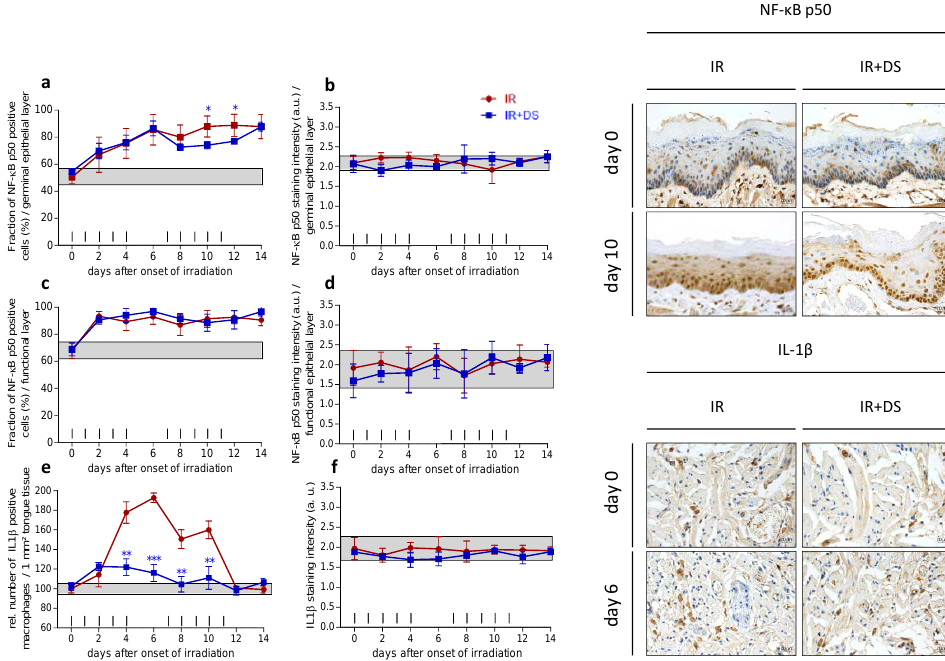
Figure 3. Effect of DS on irradiation-induced inflammatory changes. The relative number of NF- κ B p50 positive epithelial cells and their respective staining intensity were analyzed in the germinal ( a , b ) and functional compartments of the lower tongue epithelium, respectively ( c , d ); IL-1 β expression occurred exclusively in macrophages, which were scored in the deeper tongue tissue ( e , f ). Data points represent the mean of 5 animals, error bars indicate ± 1 SD. The shaded areas illustrate the mean ( ± 1 SD) from 5 control animals. The fractionation protocol is indicated on top of the abscissae. Histophotographs illustrate representative inflammatory marker staining on day 0 and after irradiation without and with DS without and with DS treatment on day 10 (NF- κ B) and day 6 (IL-1 β ) of the study period. * p ≤ 0.05, ** p ≤ 0.01, *** p ≤ 0.001, Scale bar = 20 µm.